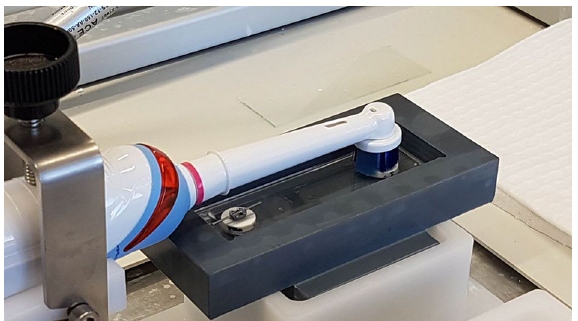
Figure 1. Test set-up of the brushing treatment using a brushing